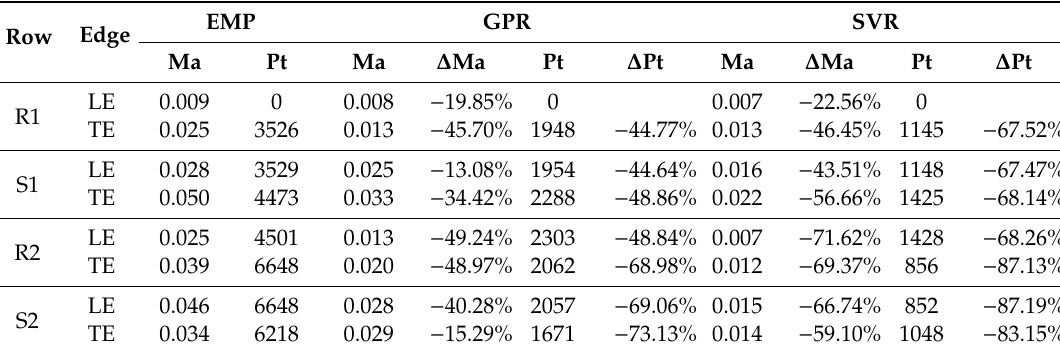
Figure 16. Meridional contour of different predictions: ( a ) Relative Mach number; ( b ) Total pressure. Table 8. RMSE of relative Mach number and total pressure compared to experimental data and the percentage of error increment relative to EMP.